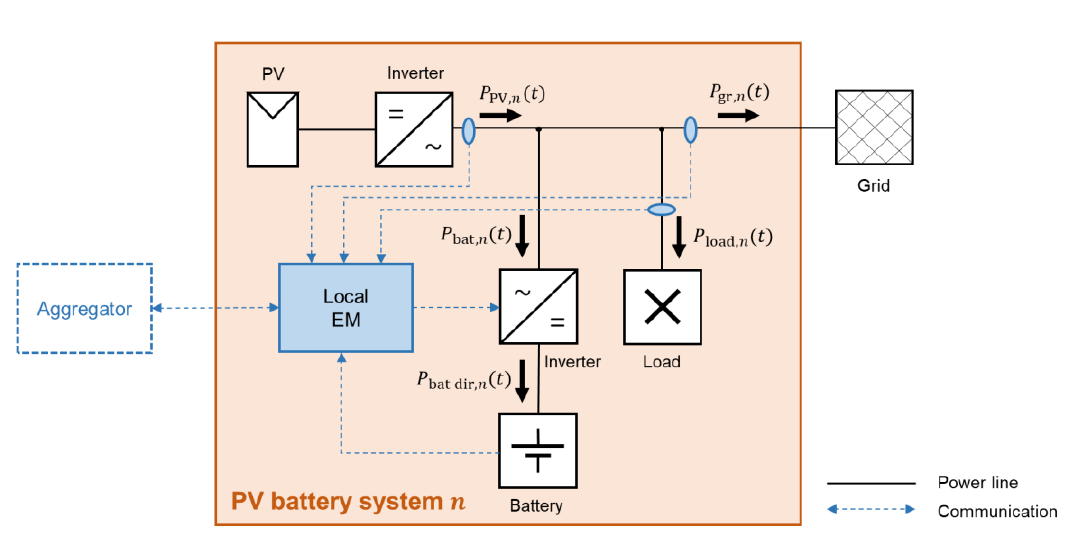
Figure 3. Topology of a single PV battery system.